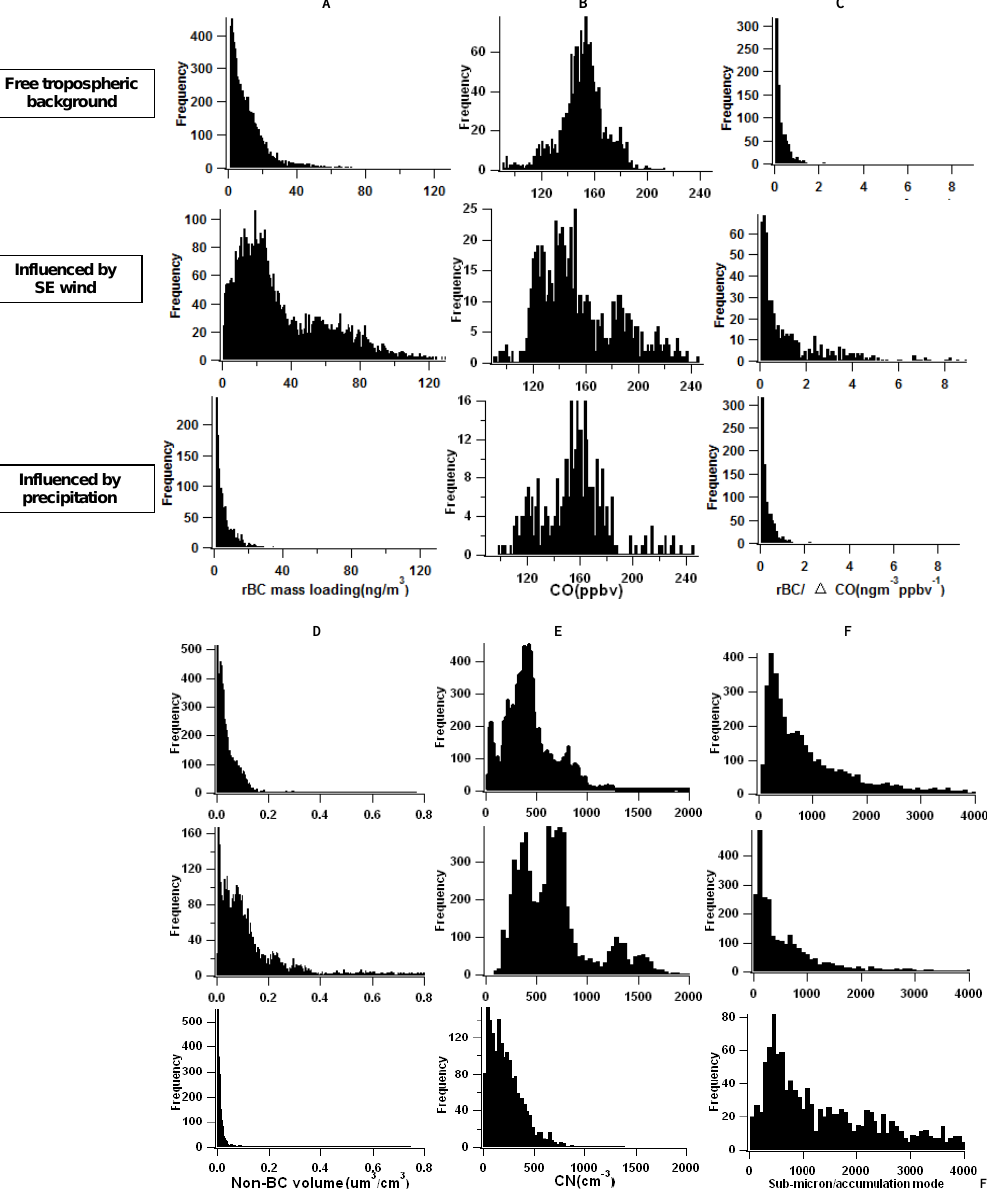
Fig. 7. Frequency distributions of aerosol and trace gas properties under free tropospheric background conditions (top row), under the influence of SE winds (middle row), and when influenced by precipitation (bottom row): column (A) rBC mass loading; column (B) CO concentration; (C) BC/ 1 CO ratio; (D) volume of non-BC particles (200-720nm); (E) CN concentration; (F) number ratio of sub-micron/accumulation